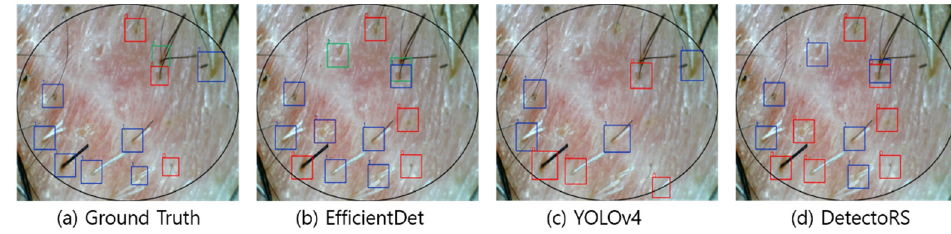
Figure 6. Visualization of detection results in a white hair image.